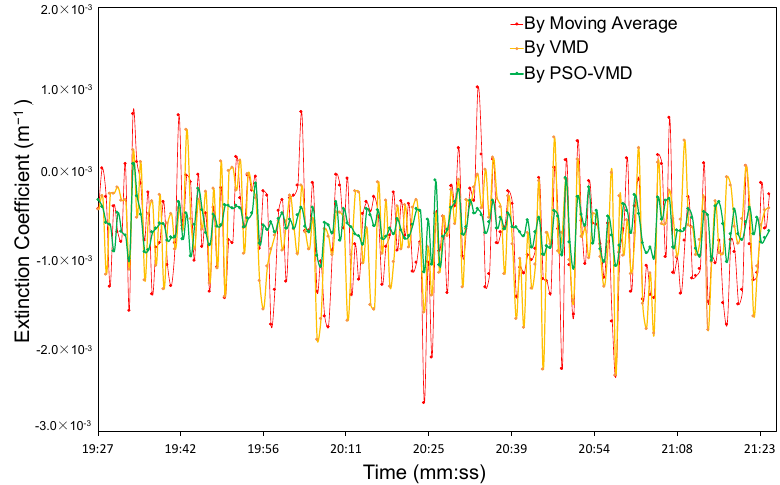
Figure 7. The extinction coefficients of atmospheric aerosol derived by three denoising methods. To evaluate the accuracy of the extinction coefficients derived from the LED-lidar echo, the extinction coefficients were derived from the surface visibility released by the Hunan provincial meteorological department and compared with the average values of the three sets of extinction coefficients calculated from LED-lidar echo. The conversion formula from visibility to extinction coefficient is expressed as Equation (14):